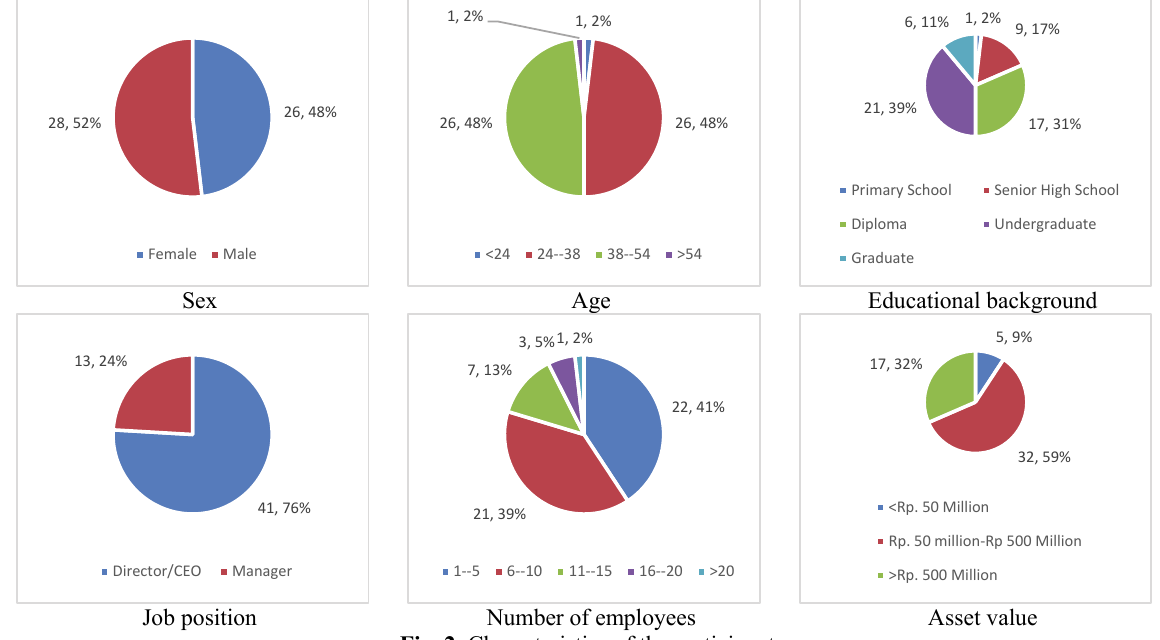
Fig. 2. Characteristics of the